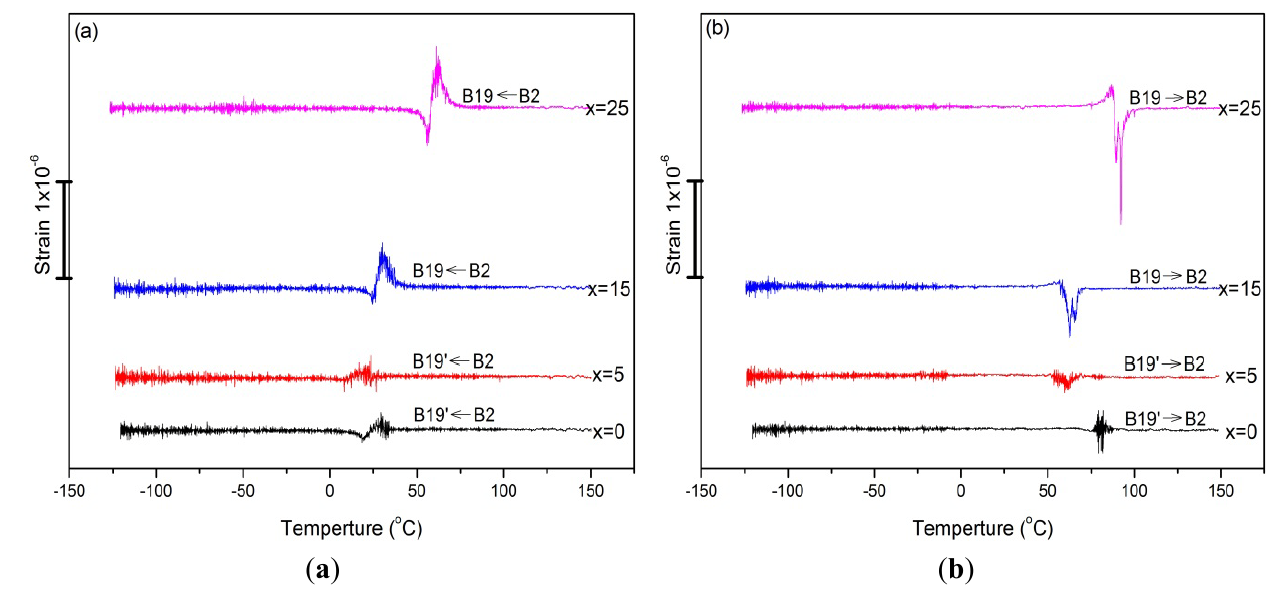
Figure 5. The strain variation curves for Ti ( a ) in cooling; ( b ) in